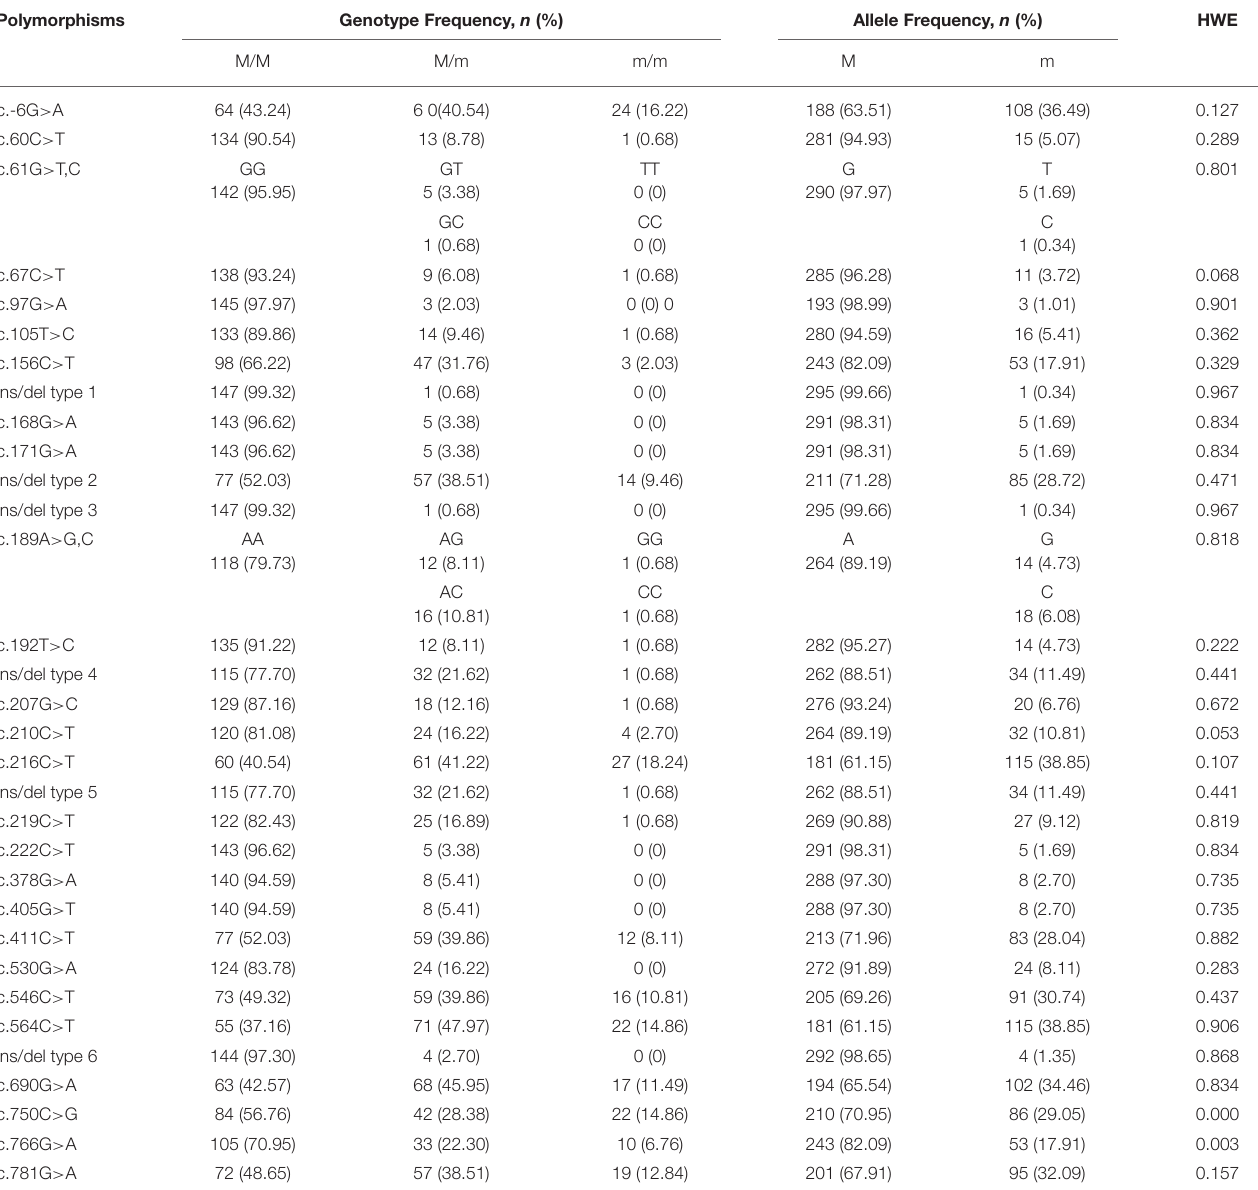
TABLE 1 | Genotype and allele frequencies of pheasant prion protein gene ( PRNP ) polymorphisms in 148 pheasants.